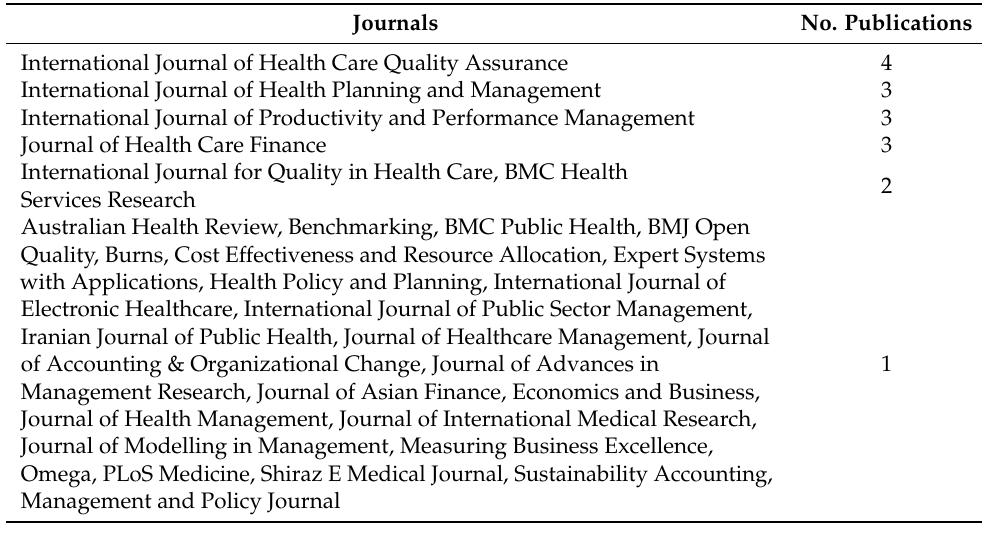
Table 3. Scientific journals of the published papers.